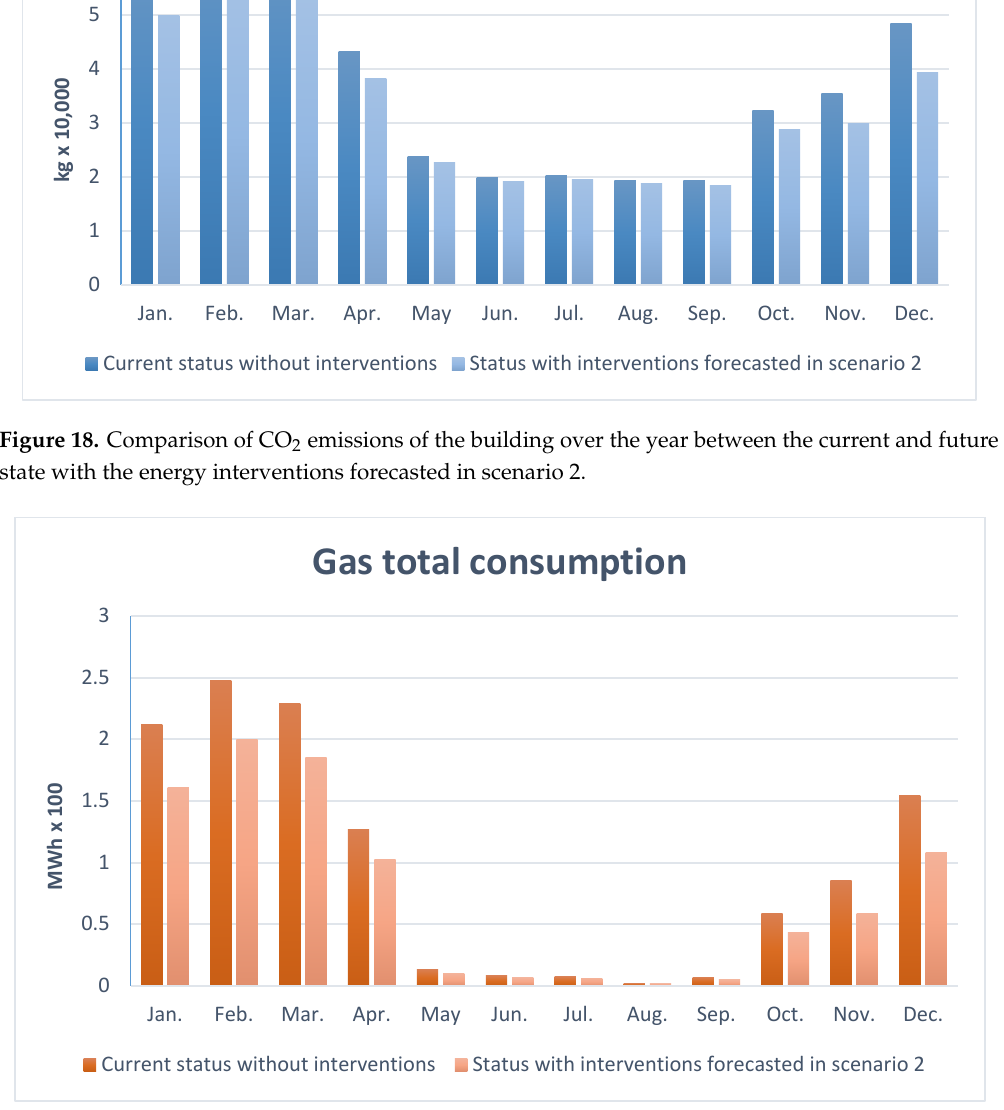
Figure 19. Comparison of total gas consumption over a year between the current and future state (with the energy interventions forecast in scenario 2).